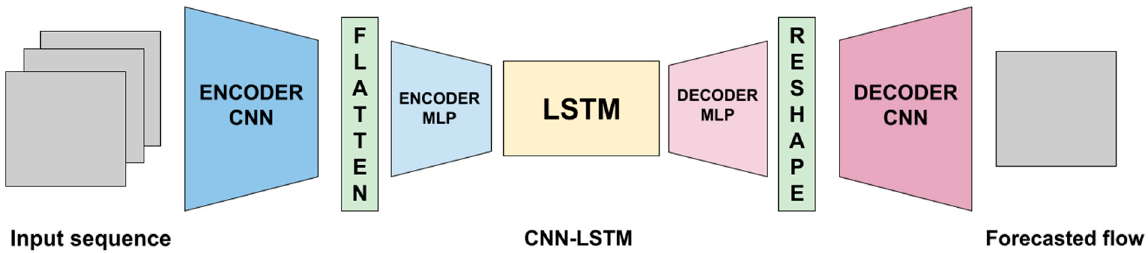
Figure 1. General layout of the tested 2D CNN + LSTM architecture.